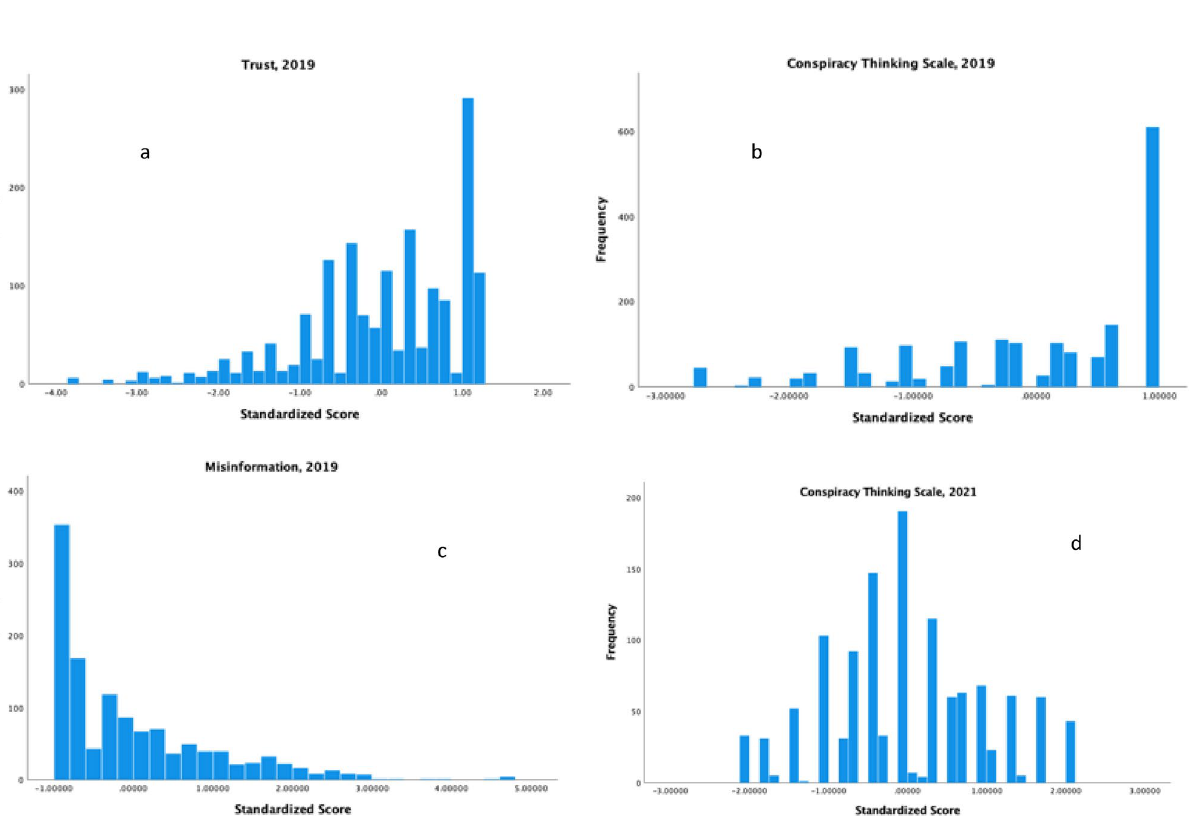
Figure 1. ( a ) Trust of health authorities, 2019; ( b ) conspiracy thinking, 2019; ( c ) misinformation, 2019; ( d ) conspiracy thinking,